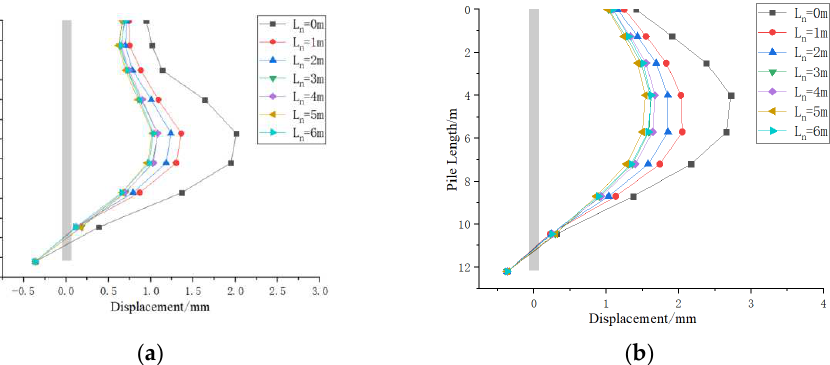
Figure 12. Comparison curve of thickness effect of grouting reinforcement with H = 8.7 m: ( a ) pile Z2; ( b ) pile Z3.